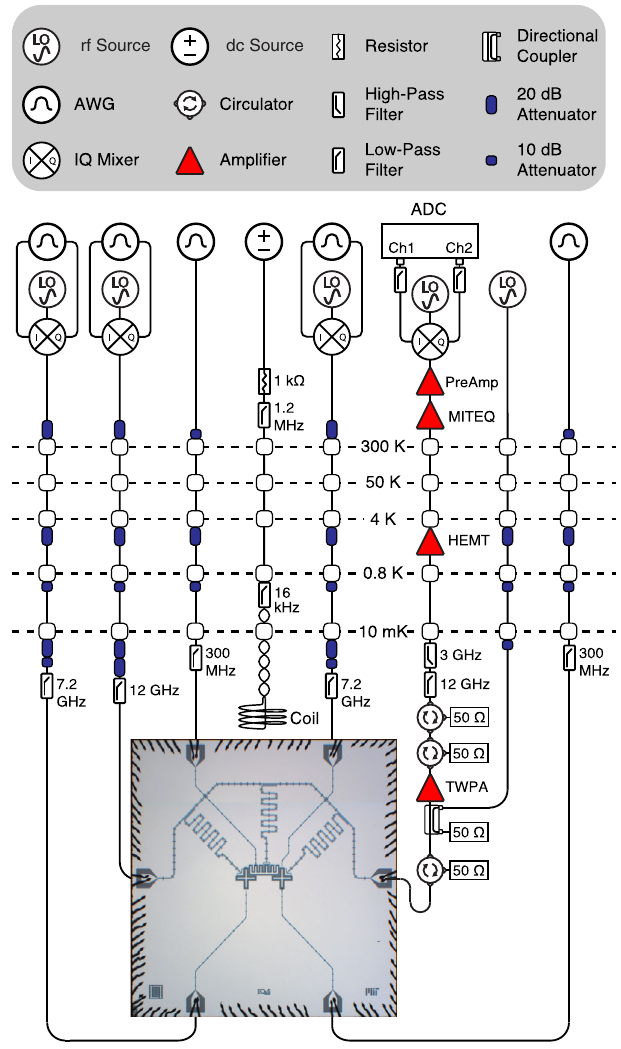
FIG. 6. A schematic diagram of the experimental